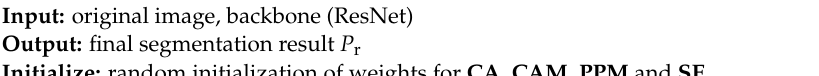
Algorithm 1: Hierarchical Feature Extraction Network (HFENet).